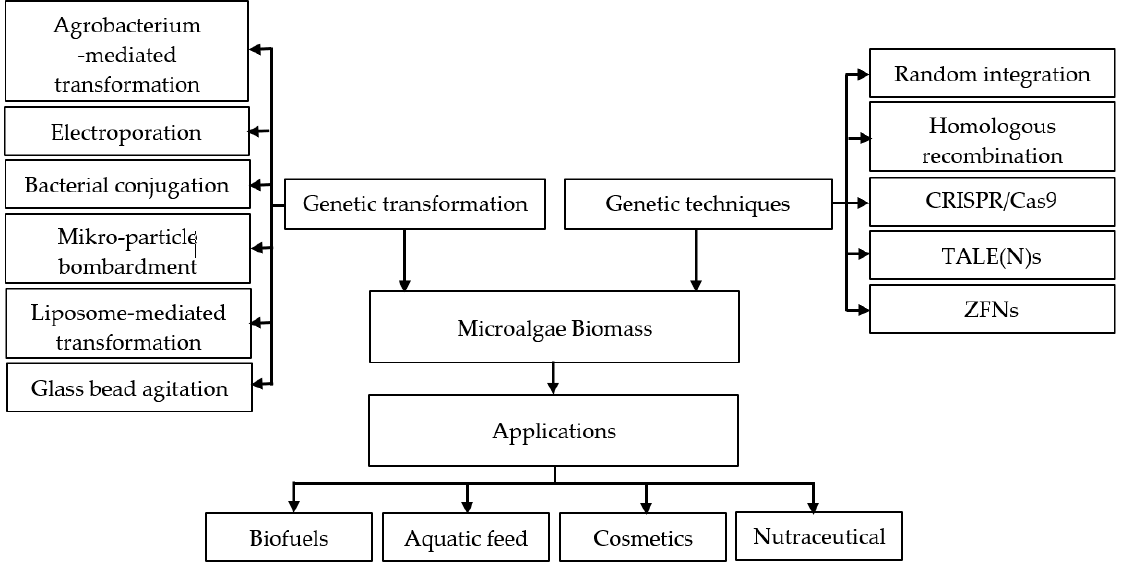
Figure 7. Genetic engineering methods used in microalgae-based technologies.